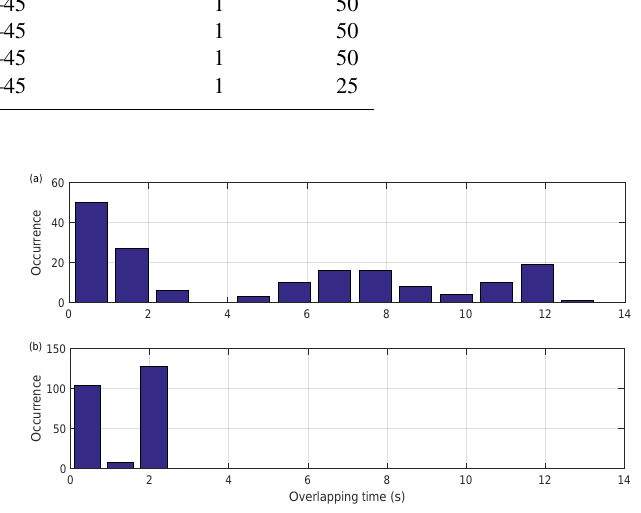
Figure 2. Histograms of the overlapping time between the different lidars for the virtual towers: (a) virtual tower 1; (b) virtual tower